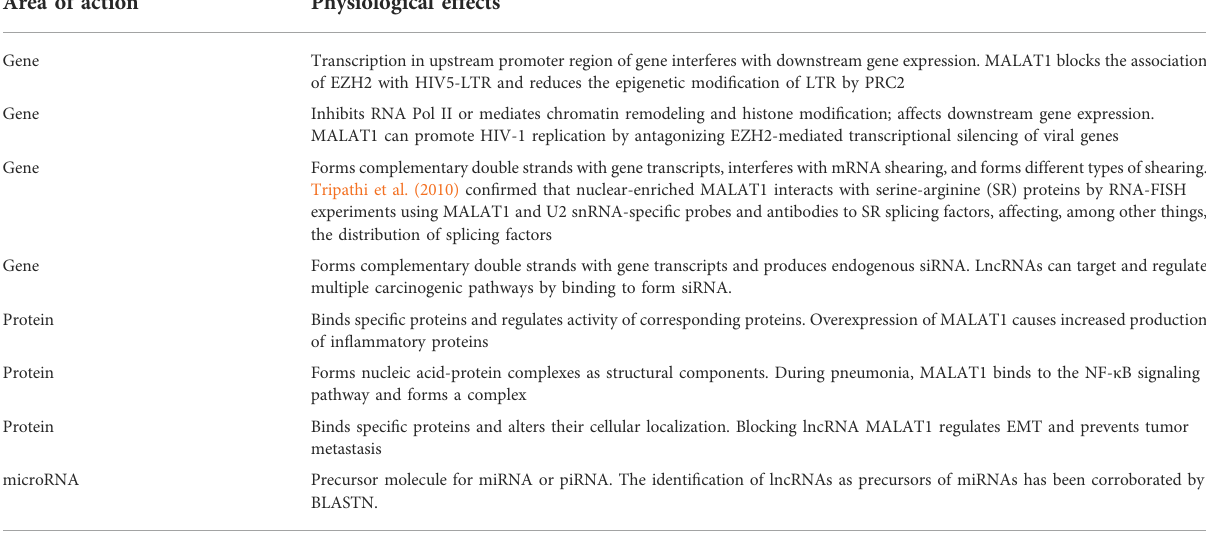
TABLE 1 Pathophysiological expression of long non-coding RNA. Area of